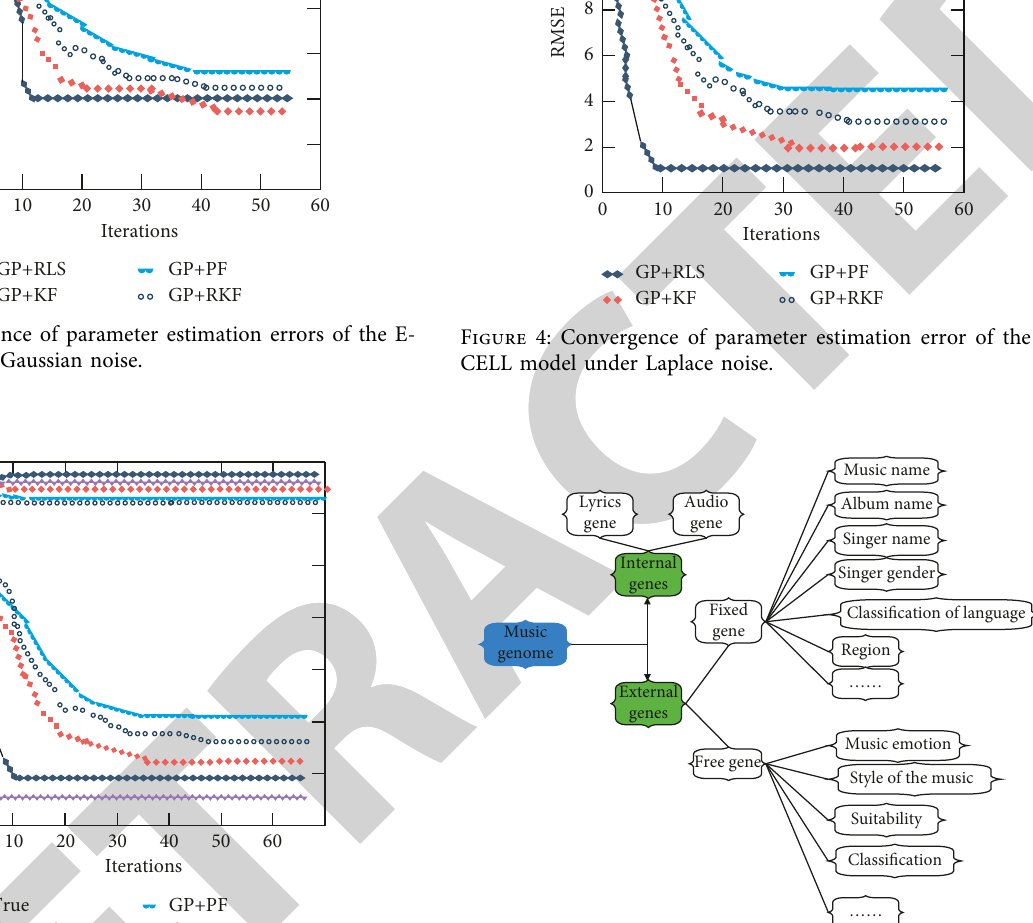
Figure 5: The structure diagram of the music